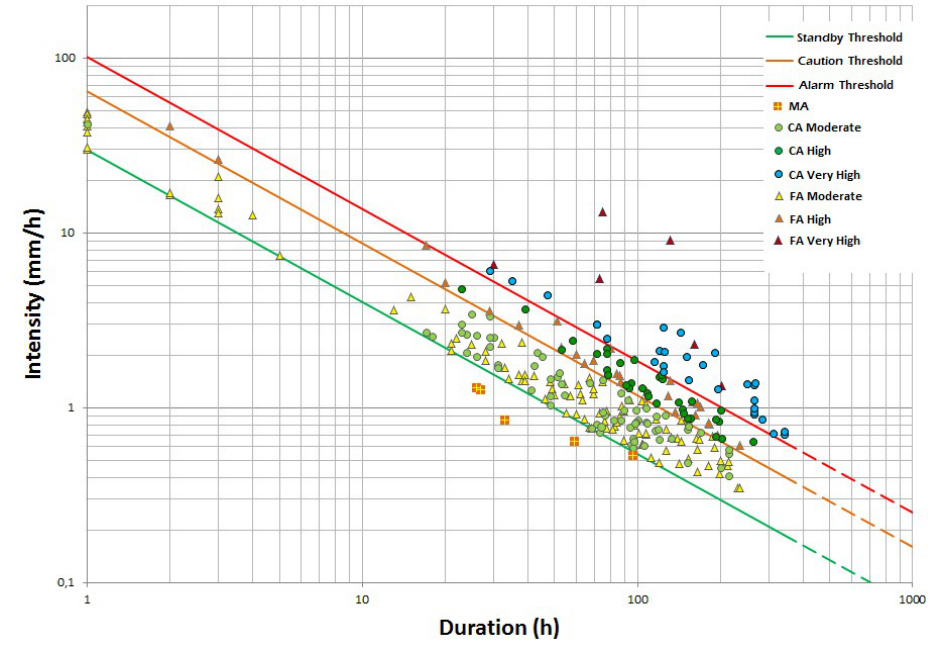
Figure 5. The thresholds for Nova Friburgo municipality. CA = correct alarm, FA = false alarm, MA = missed alarm.